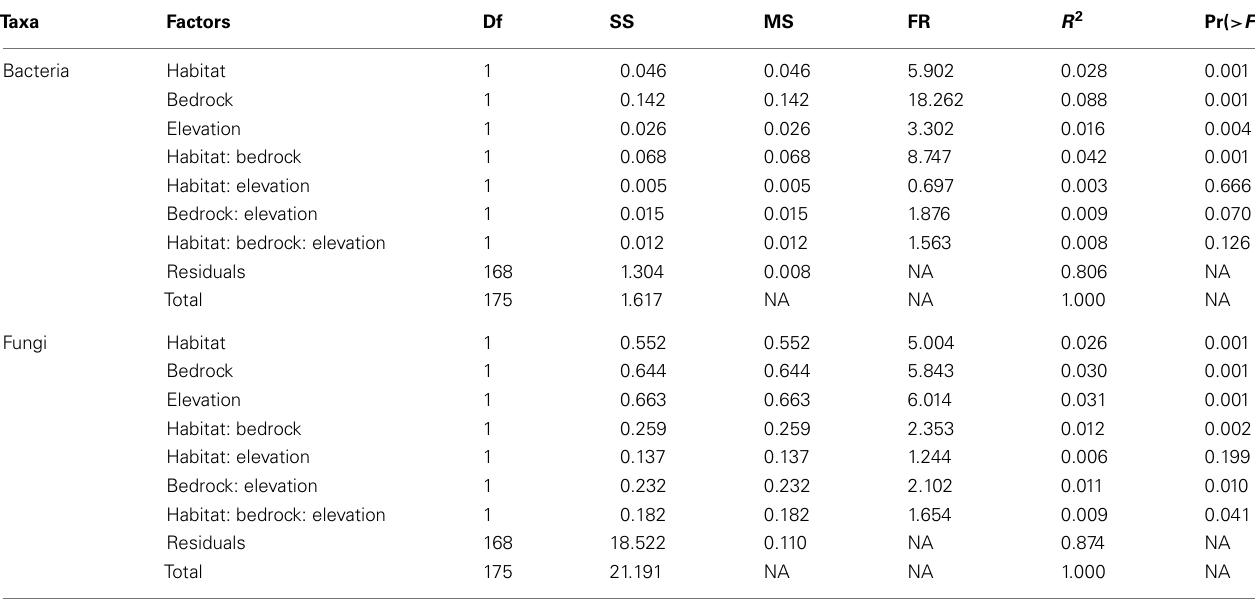
Table 1 | Respective effects of habitat, bedrock, and elevation on microbial beta-diversity, as assessed by variation partitioning on Bray–Curtis dissimilarity matrices obtained from CE-SSCP